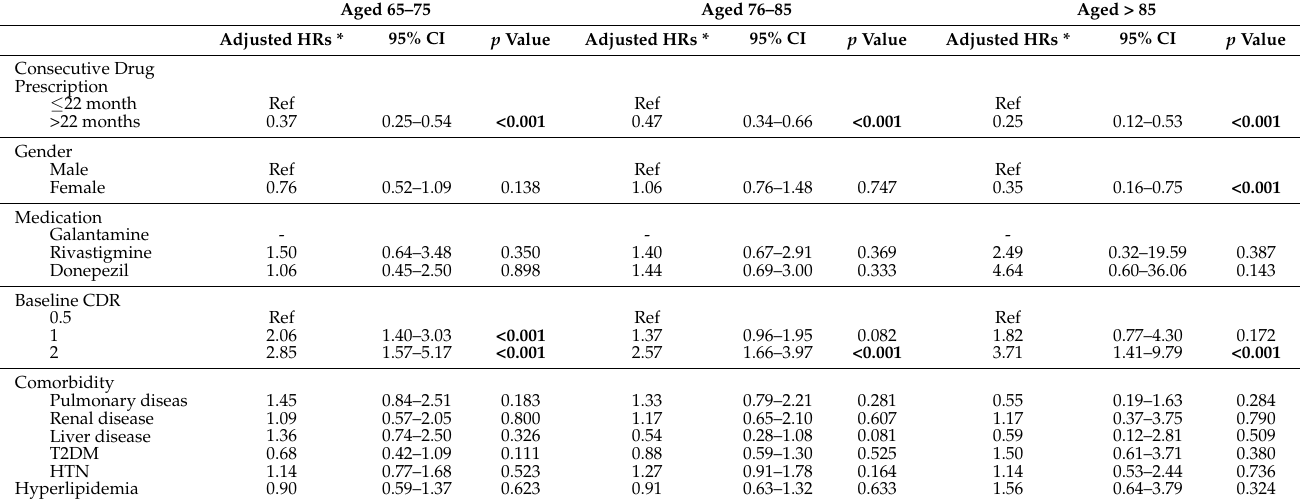
Table 3. Cox proportional hazards model for rapid decline within 2 years in patients with Alzheimer’s dementia in different age